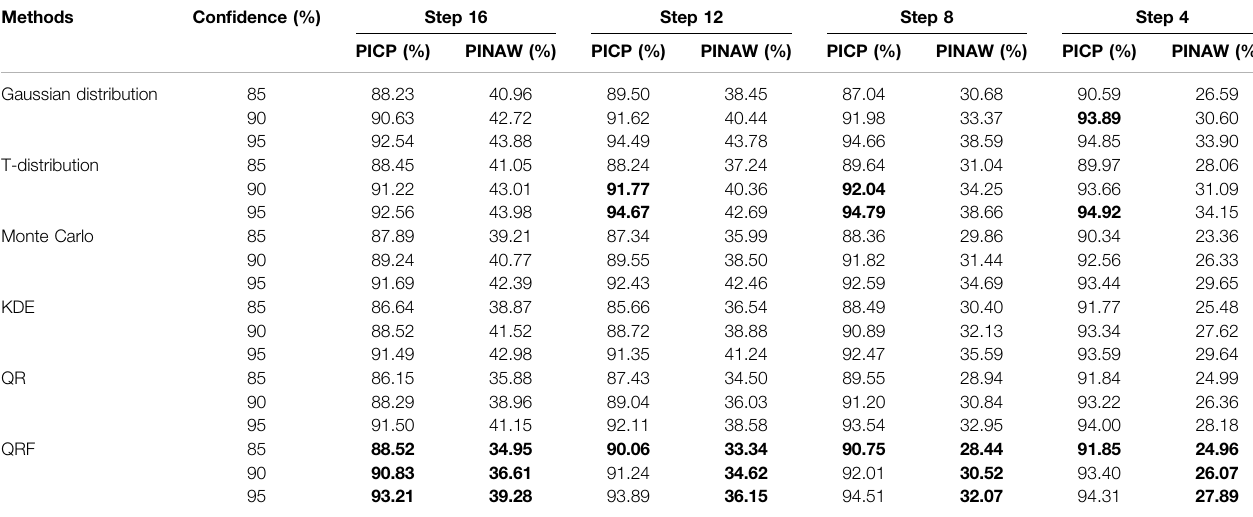
TABLE 3 | The interval predictive index of different methods of unreasonable con fi dence interval. Methods Con fi dence (%)